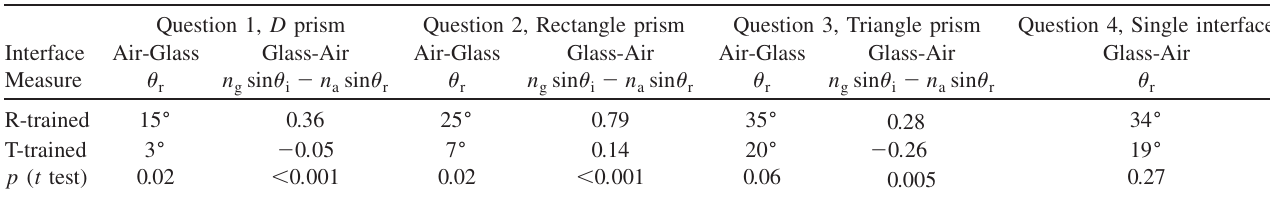
TABLE III. Summary of the angles and measures for participants in experiment 1.